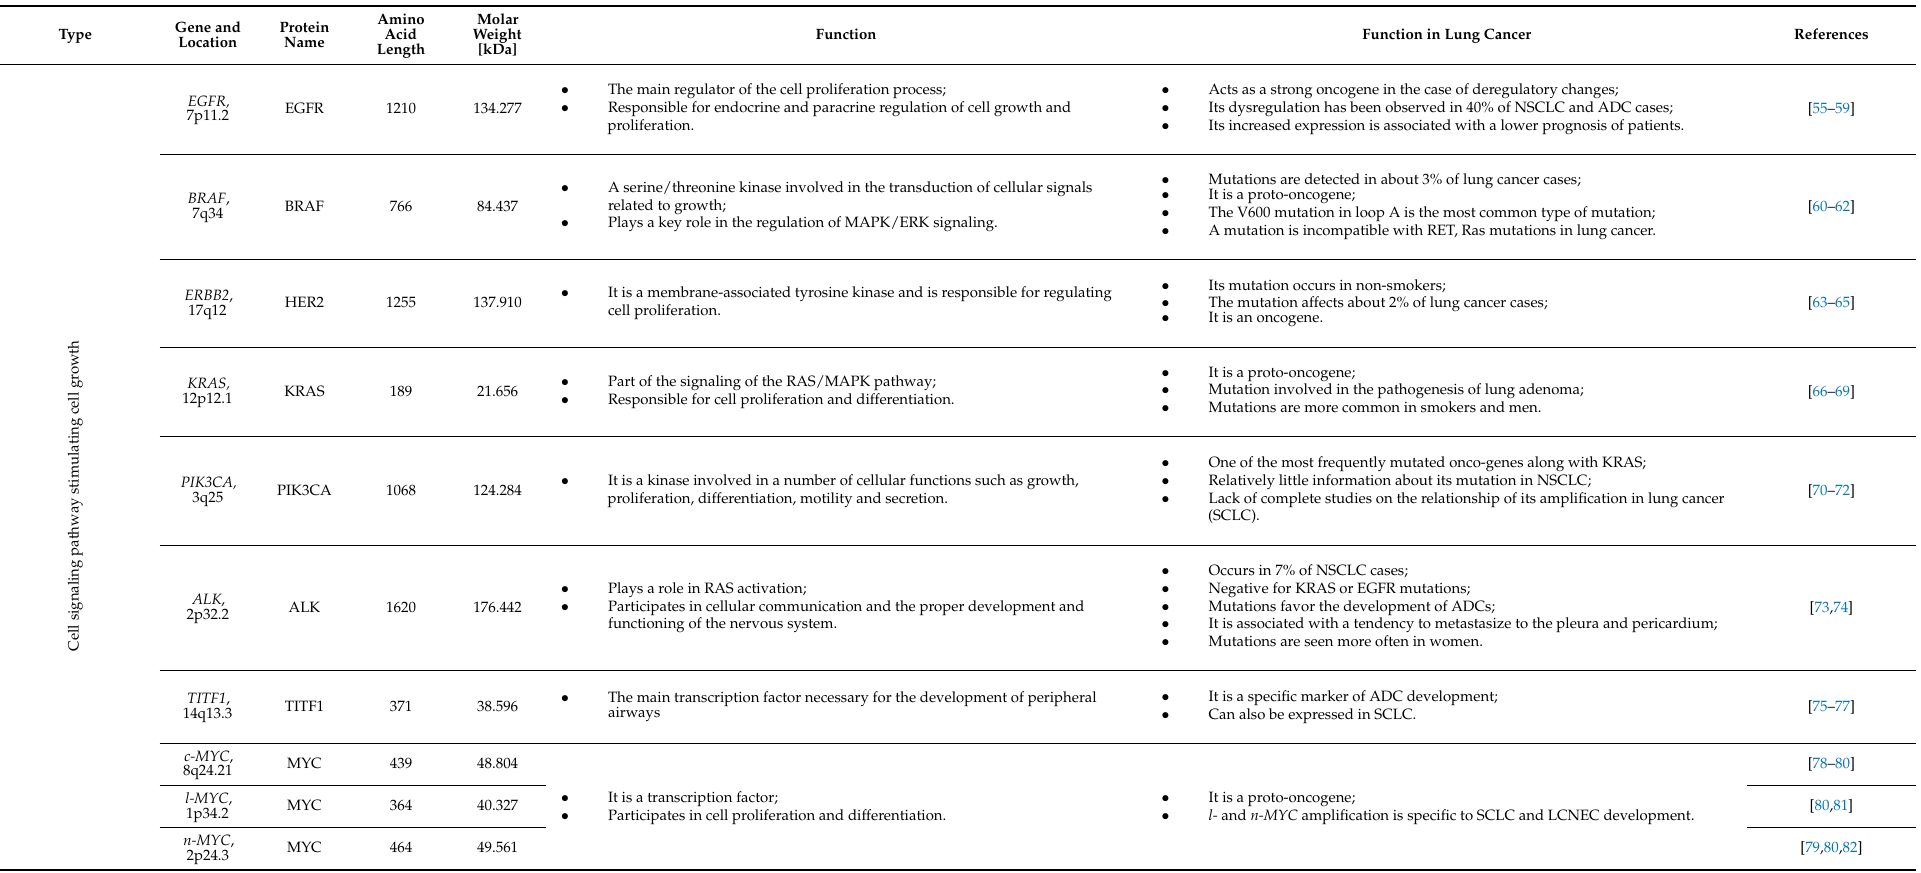
Table 2. Disturbances in cell signaling pathways involved in the development and progression of lung